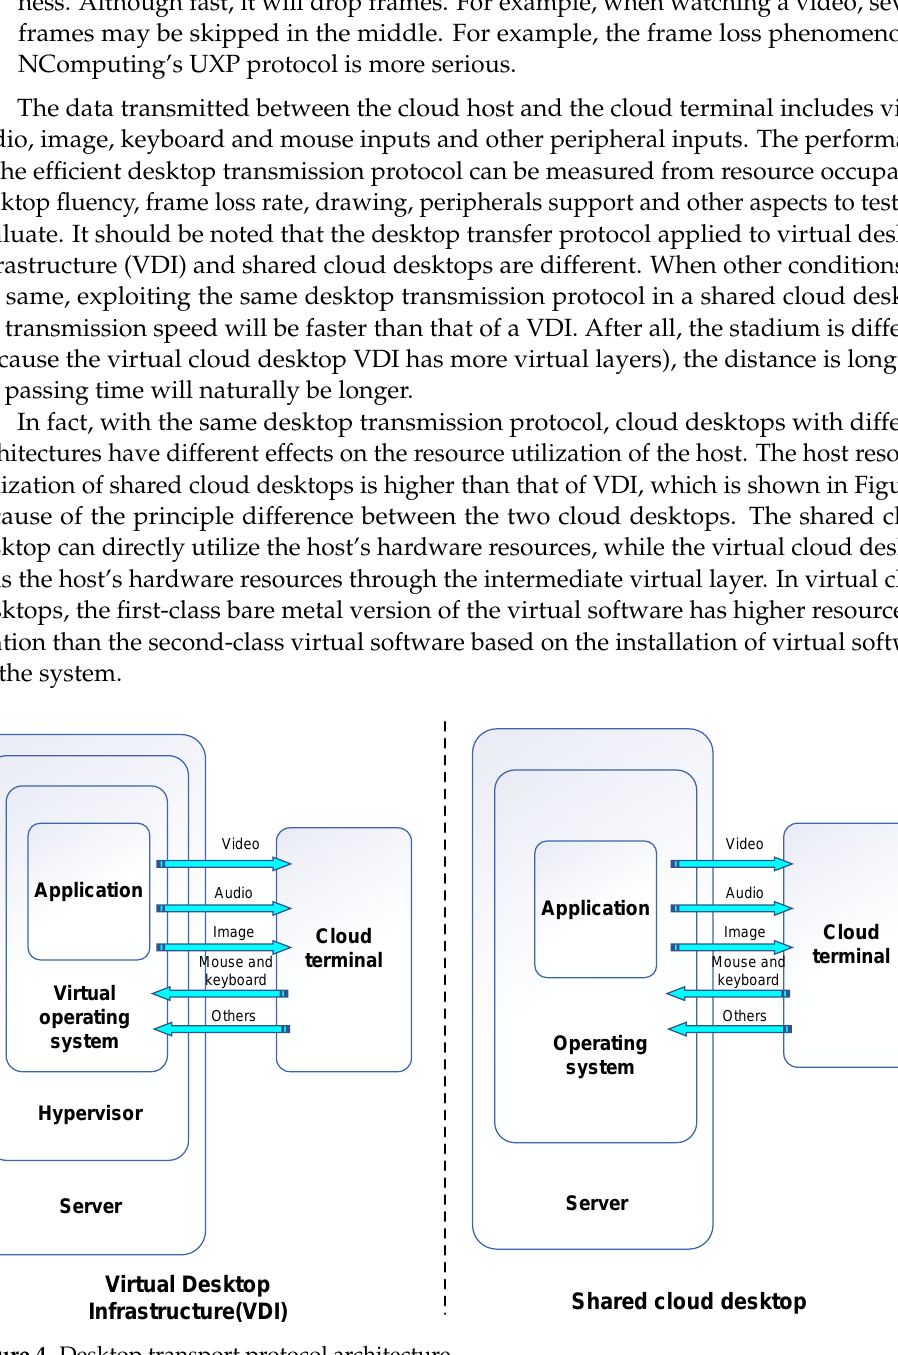
Figure 4. Desktop transport protocol